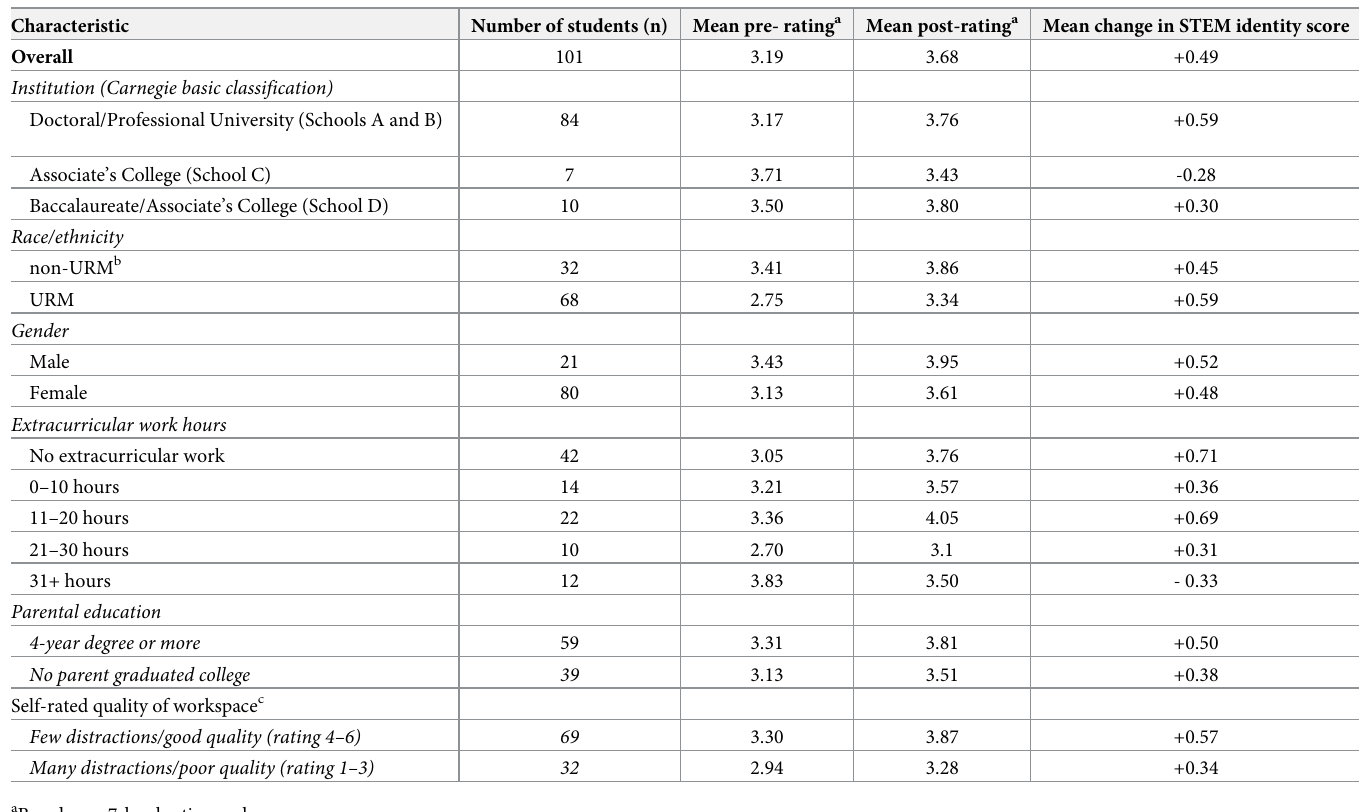
Table 6. STEM identity score changes by student